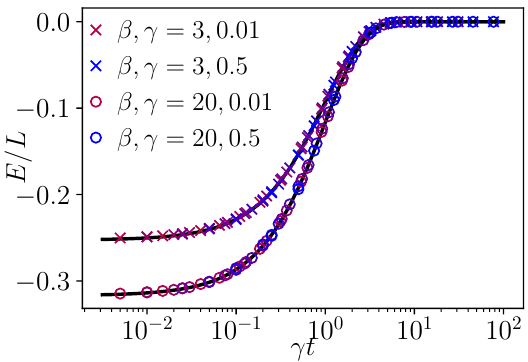
Figure 2: Heating by continuous measurement from a lower energy eigenstate at inverse temperature β = 3 and β = 20. It is chosen by randomly filling the or- ( 1 + e βε ( k ) ) − 1 . bital with momentum k with probability given by the Fermi factor 1 2 | H | ψ 〉 / L is plotted for measurement rates The average energy density E / L = 〈 ψ t t are γ = 0.01,0.02,0,05,0.1,0.2,0.5 (markers, from red to blue), as a function of rescaled time γ t . The predictions from GHD (21) are plotted in solid